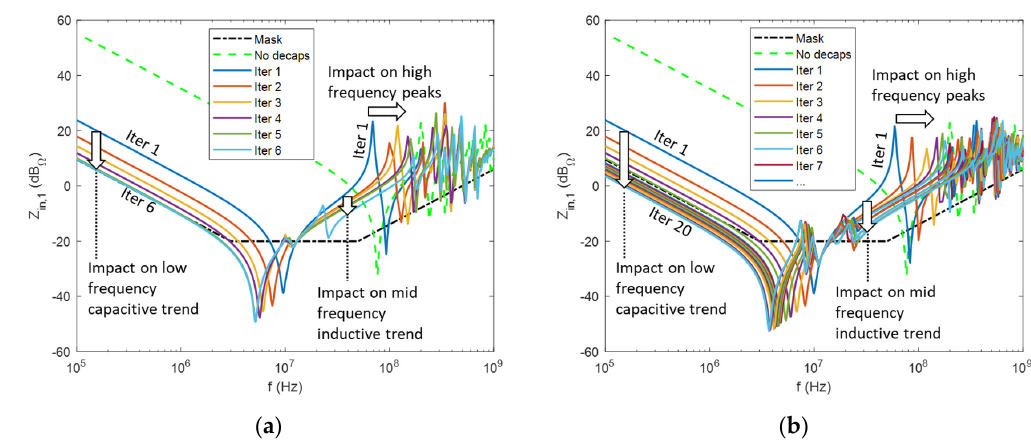
Figure 8. Iterative evolution of the input impedances at Port P 1 for the case of ( a ) maximum six iterations, and ( b ) maximum 20 iterations (number of decaps).